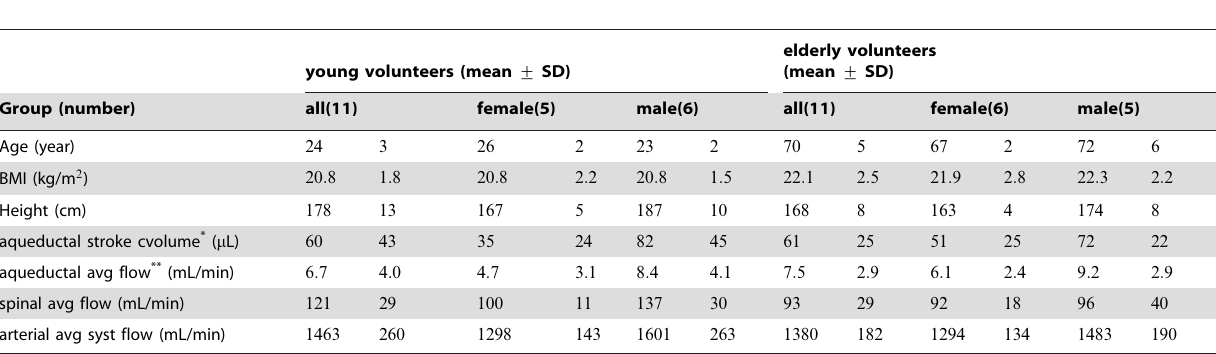
Table 1. Mean and standard deviation (SD) of subjects’ age, body mass index (BMI) and height, as well as aqueductal stroke volume [101] and average flow rate [11],